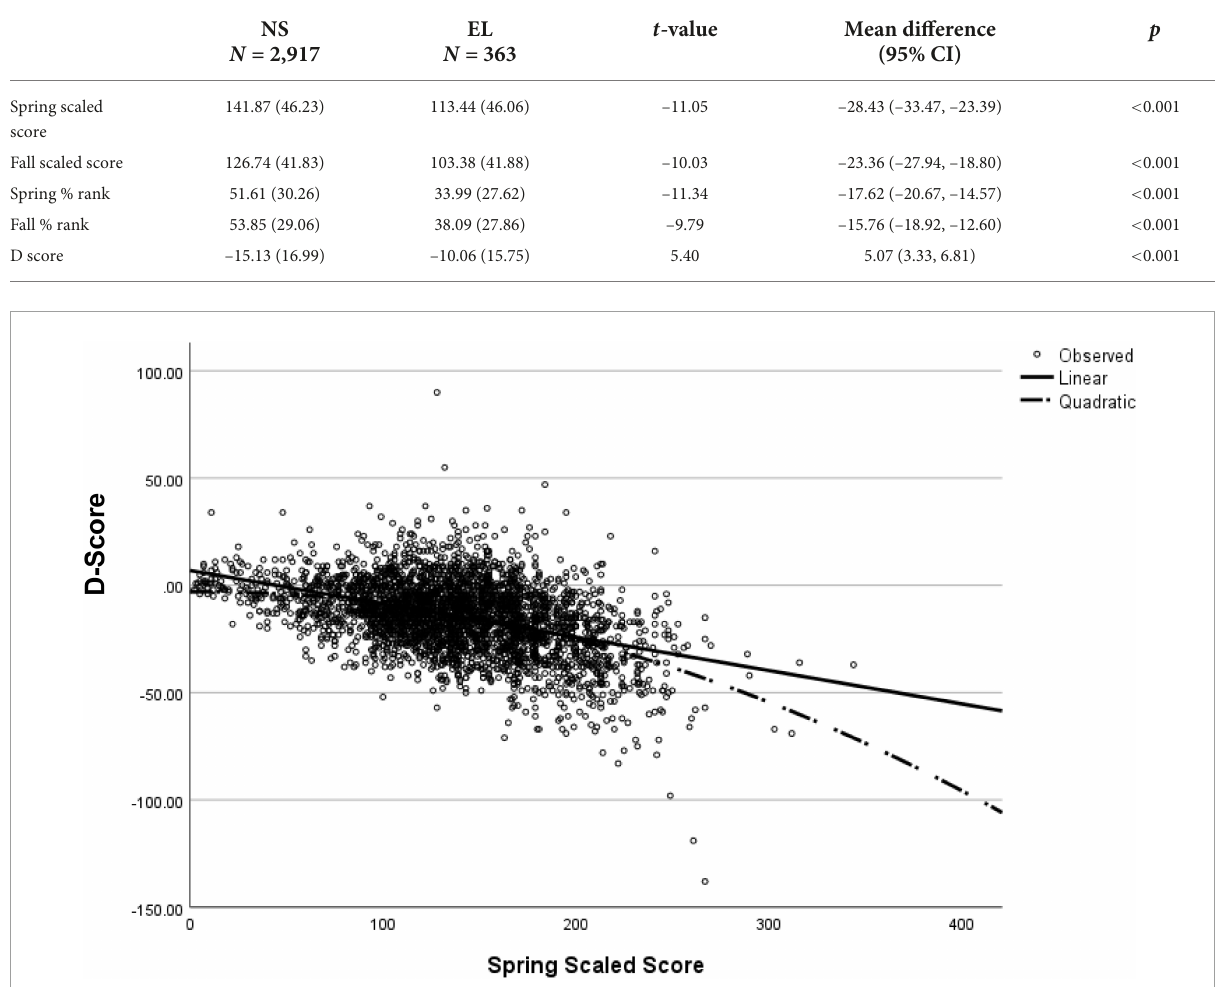
FIGURE1 Scatter plot and curve estimation analysis showing the linear and quadratic relationship between spring performance and performance change over the summer (D-score).